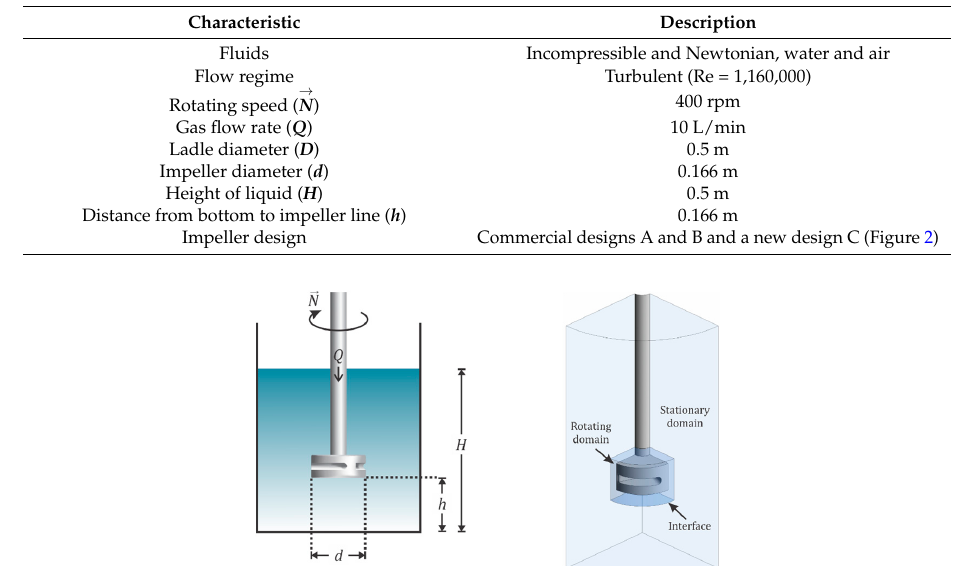
Table 1. Characteristics of the system.